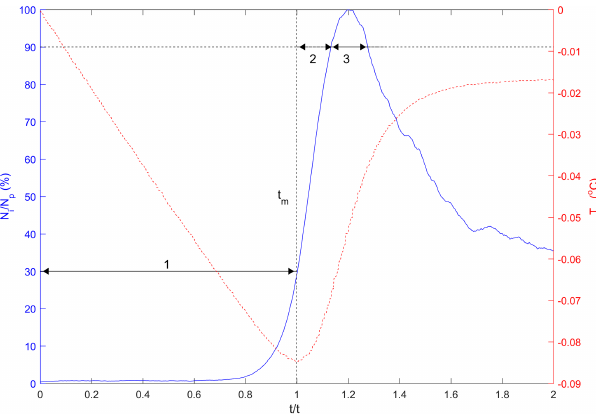
Figure 8. Typical plot illustrating the three time phases (labelled as 1, 2 and 3) with the dimensionless number of particles or flocs per image (in blue) plotted as a function of dimensionless time with a superimposed supercooling curve (in red). N i is the number of particles or flocs per image, N p is the peak number of particles or flocs per image, T w is the water temperature ( ◦ C), t is the time (s), t c is the time of cooling (s) and t m is the time of minimum temperature (s). Note that this plot was generated from a freshwater experiment where the freezing temperature T f is 0 ◦